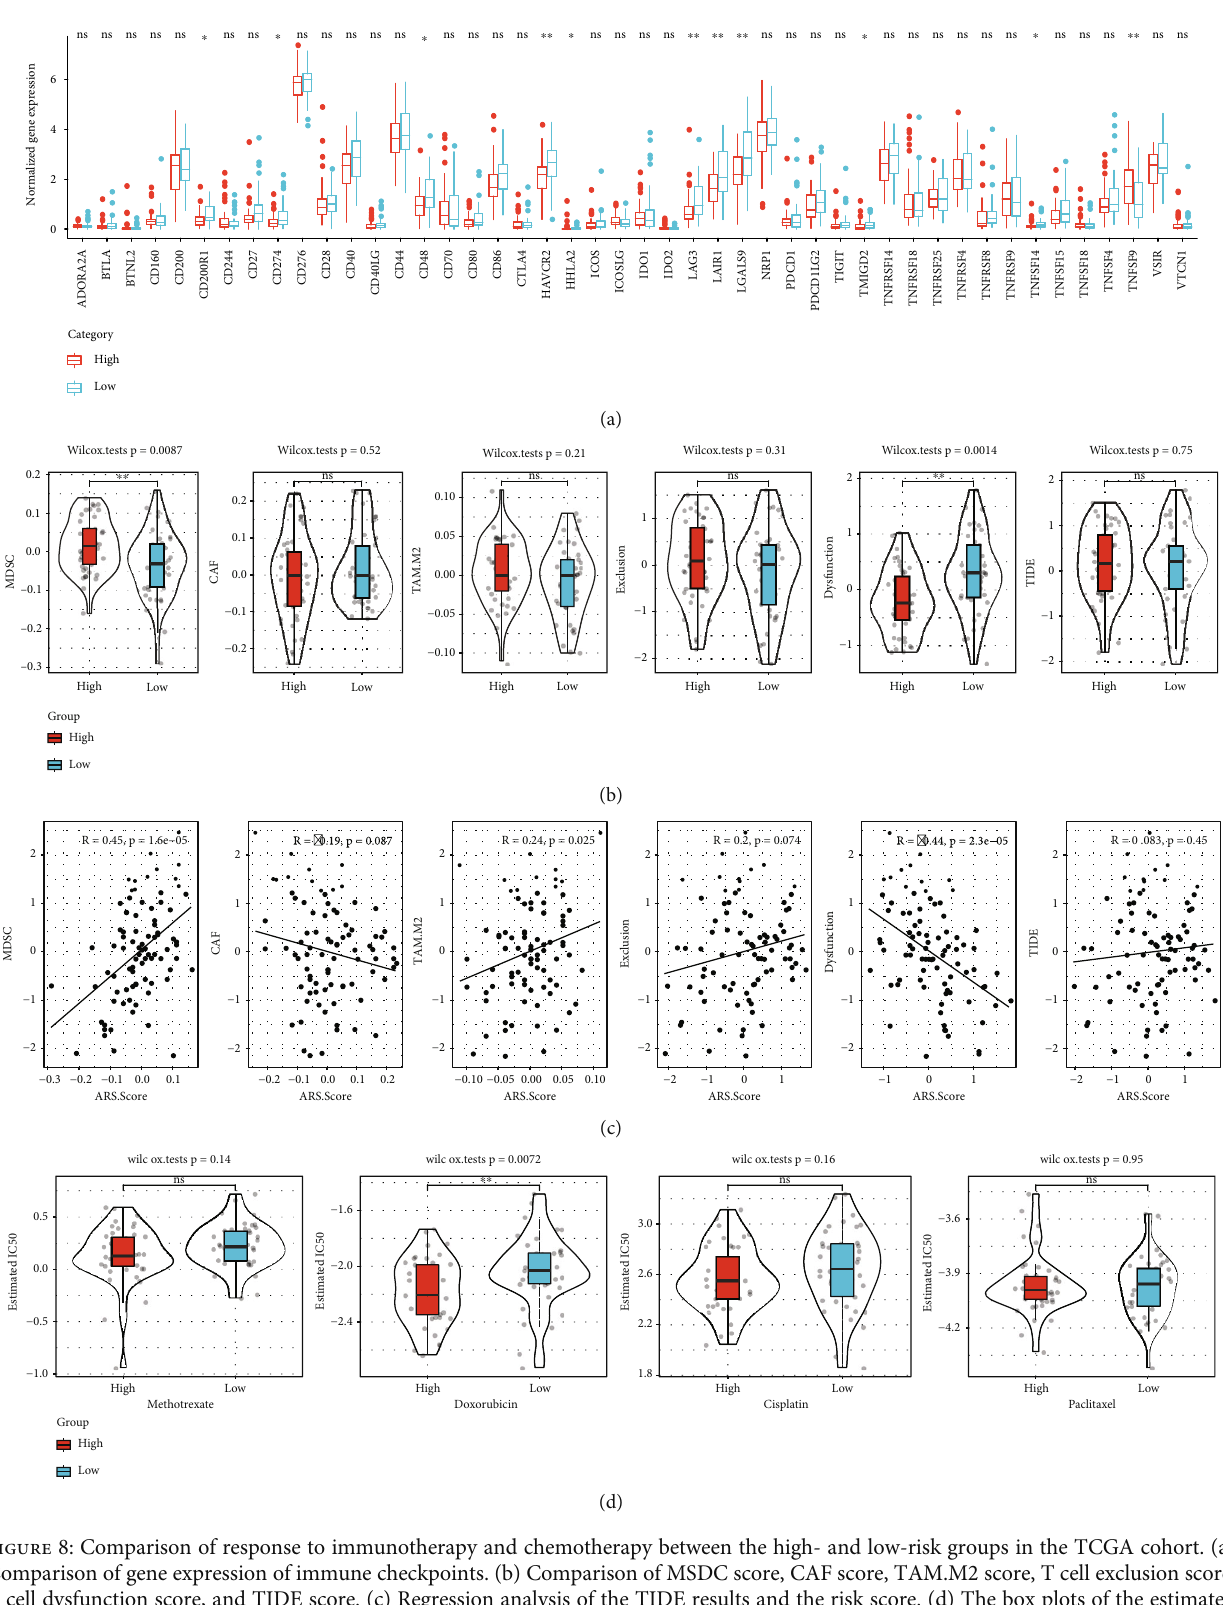
Figure 8: Comparison of response to immunotherapy and chemotherapy between the high- and low-risk groups in the TCGA cohort. (a) Comparison of gene expression of immune checkpoints. (b) Comparison of MSDC score, CAF score, TAM.M2 score, T cell exclusion score, T cell dysfunction score, and TIDE score. (c) Regression analysis of the TIDE results and the risk score. (d) The box plots of the estimated for cisplatin, doxorubicin, methotrexate, and paclitaxel. ns: no signi fi cance. ∗ P < 0 : 05, ∗∗ P < 0 : 01, ∗∗∗ P < 0 : 001,and ∗∗∗∗ P < 0 : 0001 IC 50